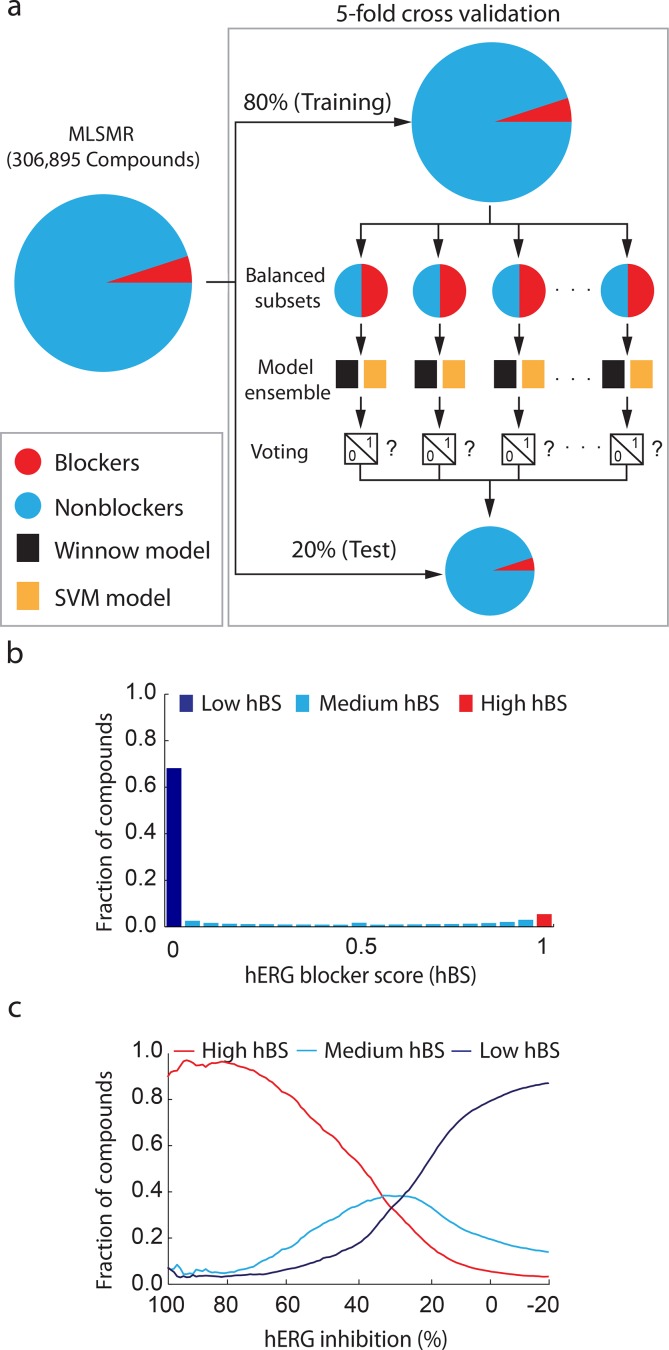
Ensemble modeling segregates compound populations by hERG liability.(a) Schematic of ensemble voting procedure. MLSMR compounds (left) are divided in 5 test folds (bottom), each receiving binary votes from an ensemble of hERG classifiers (center right) developed using balanced batches of the 80% training set not included in each test fold (top right). (b) The average vote of hERG blocker over all models in the ensemble is recorded as a hERG Blocker Score (hBS). Compounds with high hBS (red histogram bar) have consistent blocker classification, while those with low hBS (dark blue histogram bar) have consistent nonblocker classification. Compounds with intermediate hBS score are denoted by light blue histogram bars. (c) Distribution of hERG inhibition (10 μM) for compounds with High (>0.95), Intermediate (0.05<hBS<0.95) and Low (<0.05) hBS.